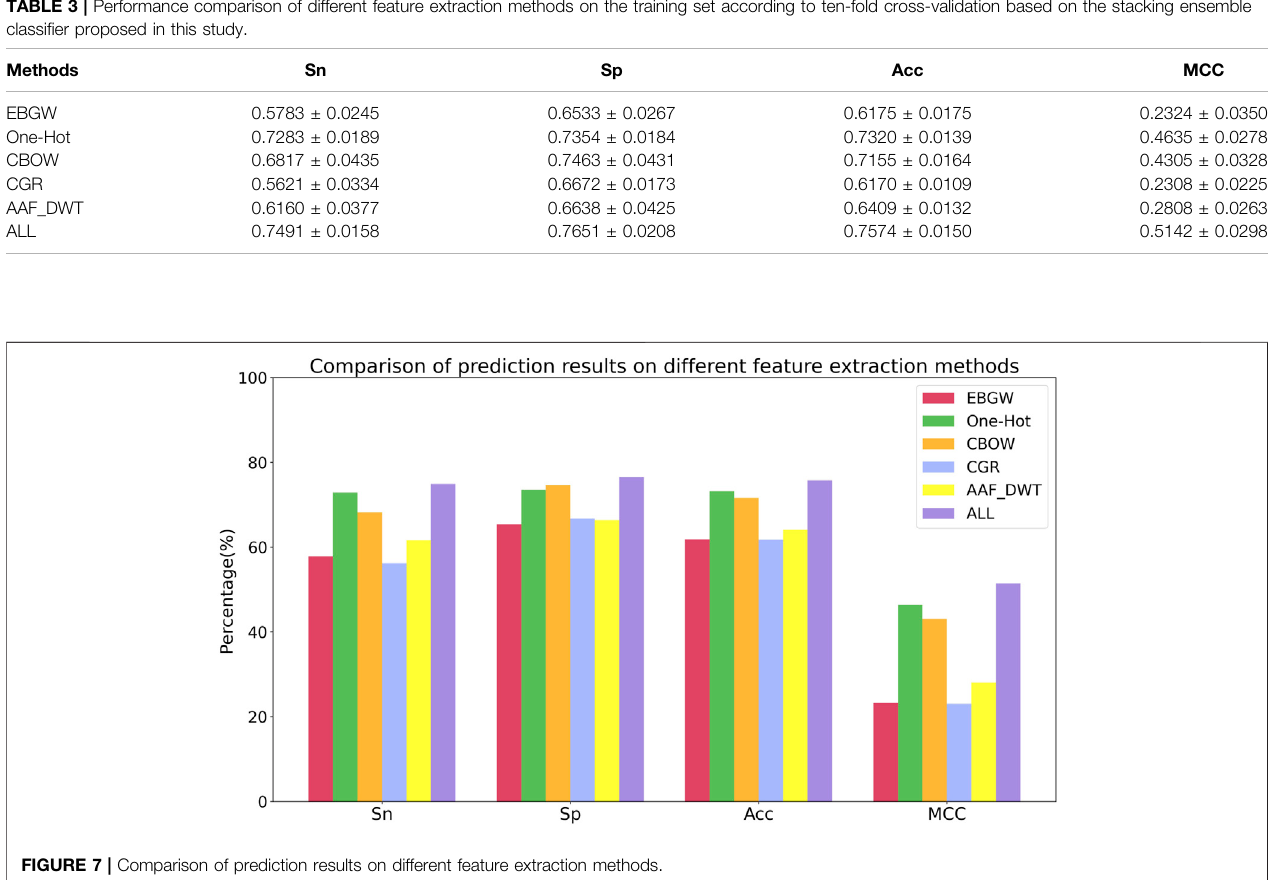
Frontiers in Cell and Developmental Biology |